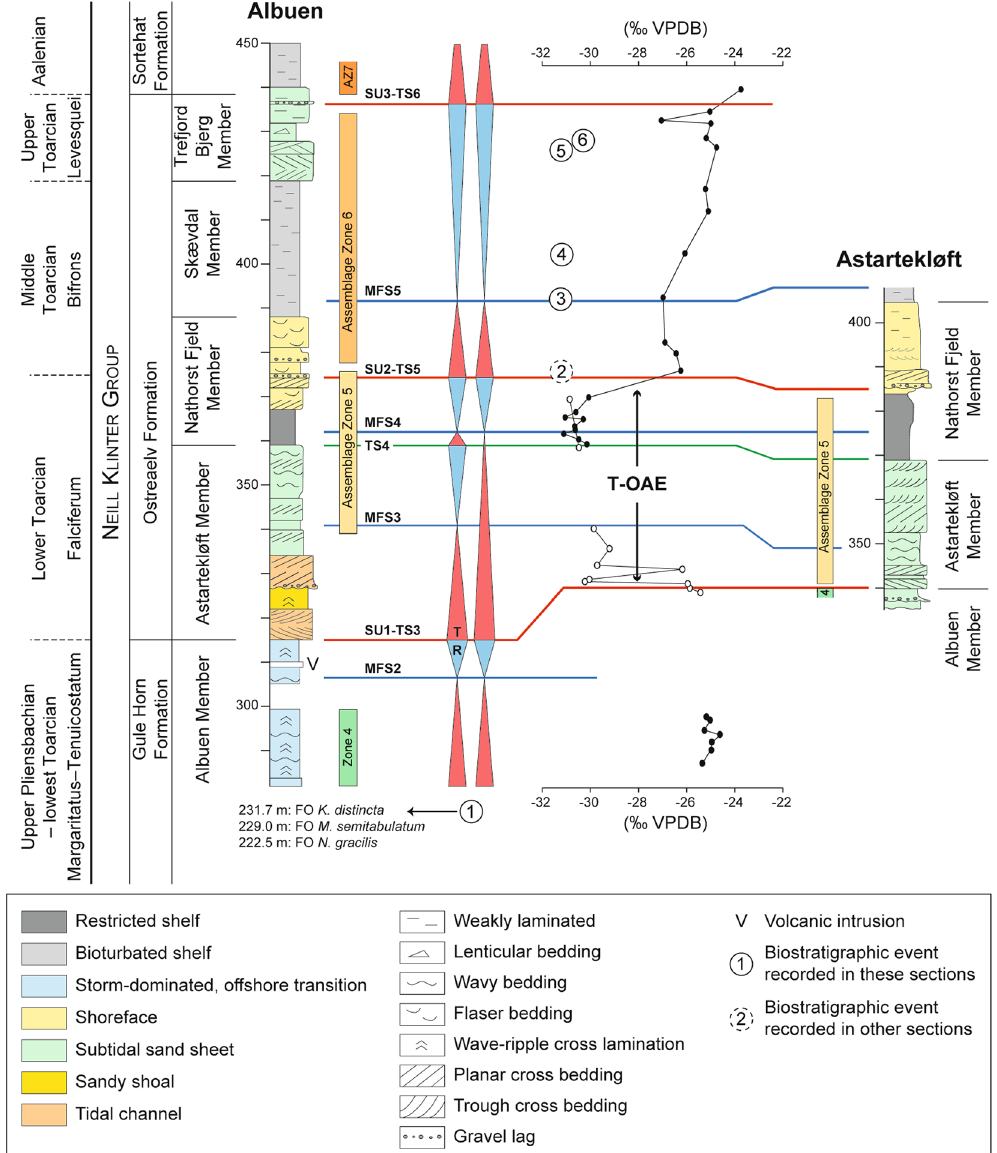
Figure 5. Lithostratigraphy and biostratigraphy of the Albuen and Astartekløft sections (modified after ref. 61 ). The assemblage zones refer to the palynomorph assemblage zones of Koppelhus and Dam 61 : Assemblage zone 4: Upper Pliensbachian, Assemblage zone 5: Lower Toarcian s.l ., Assemblage zone 6: Upper Toarcian s.l ., Assemblage zone 7: Aalenian. Biostratigraphic events: (1) First occurrences (FO) of Nannoceratopsis gracilis, Mancodinium semitabulatum and Kekryphalospora distincta ; (2) FO of Parapassolotheuthis polita ; (3) FO of Parvocysta sp.; (4) FO of Parvocysta eumekes ; (5) FO of Parvocysta elongata ; and (6) FO of Callialasporites spp. The lithostratigraphic units and sequence stratigraphic interpretation are following the interpretations of Ahokas et al . (ref. 63 ). For the carbon isotope curve, the black dots represent analyses from the Albuen section, and the white dots analyses from the Astartekløft